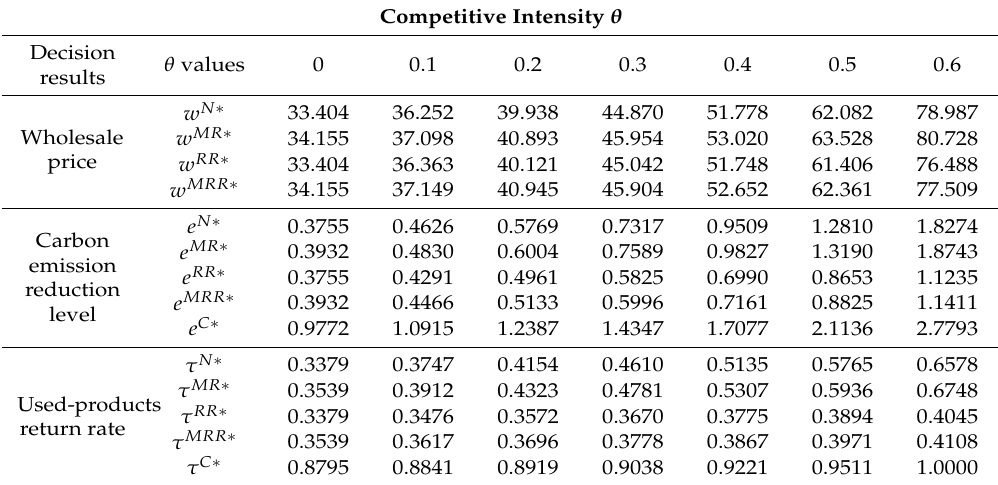
Table 2. The influence of competition intensity on the manufacturer’s decision